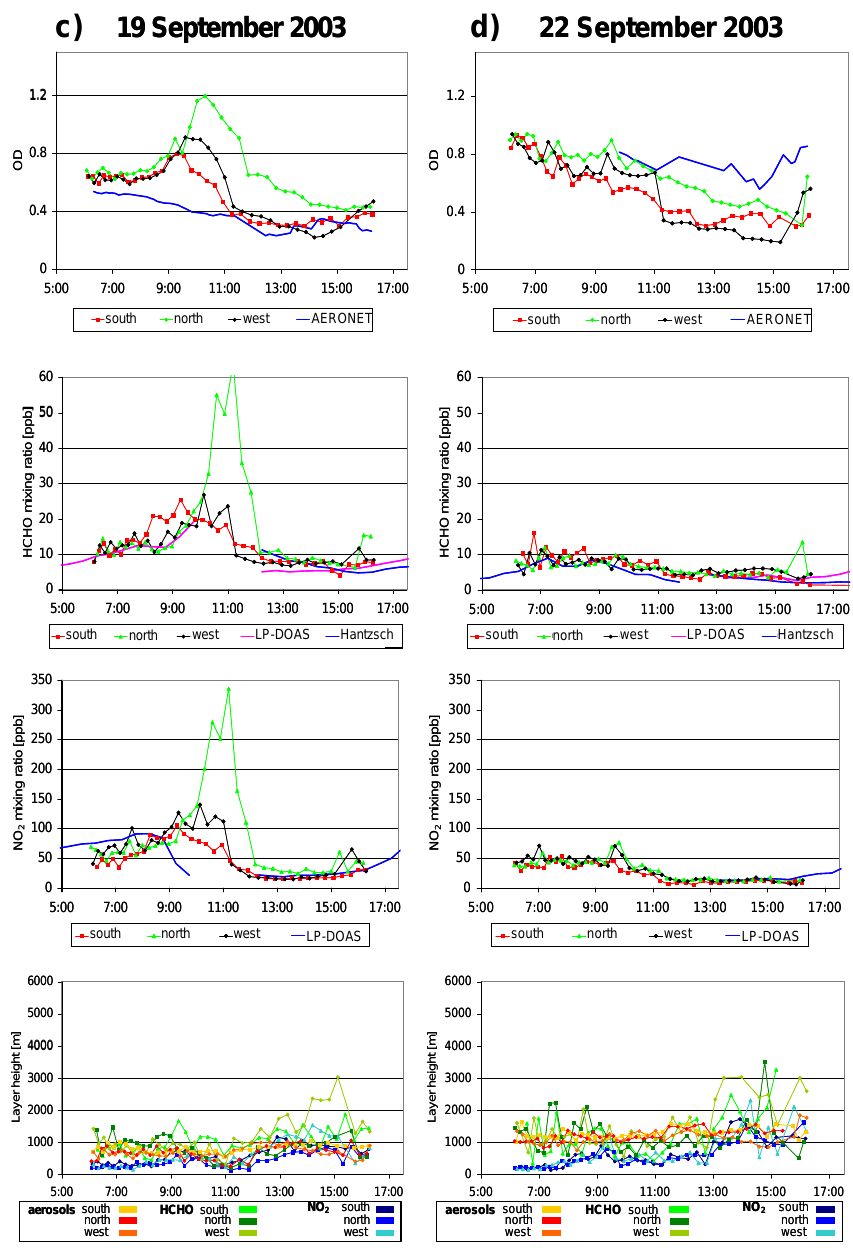
Fig. 15 Retrieval results of the AOD, mixing ratios of HCHO and NO 2 , and layer heights from individual elevation sequences for selected days. Also the results for the LP-DOAS and Hantzsch instrument and the AERONET AOD (at Ispra) are shown for